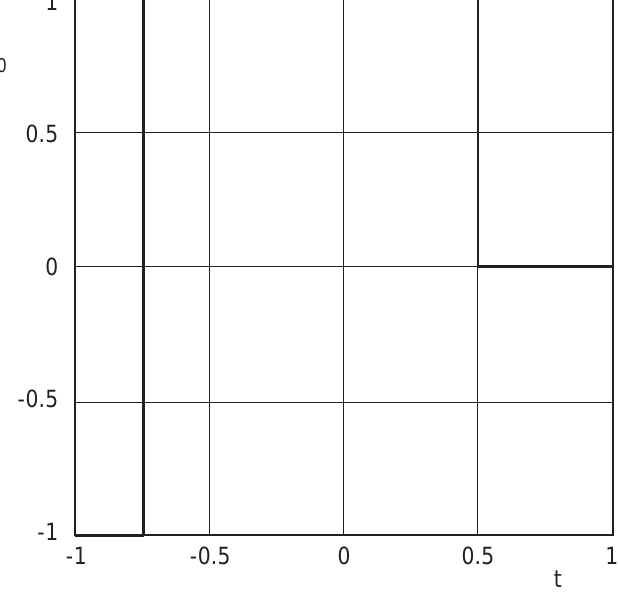
Fig. 2. Time history of the optimal pre-acting control